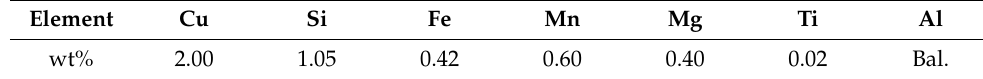
Table 1. Chemical composition of the as-received alloy. Element Cu Si Fe Mn Mg Ti Al wt%